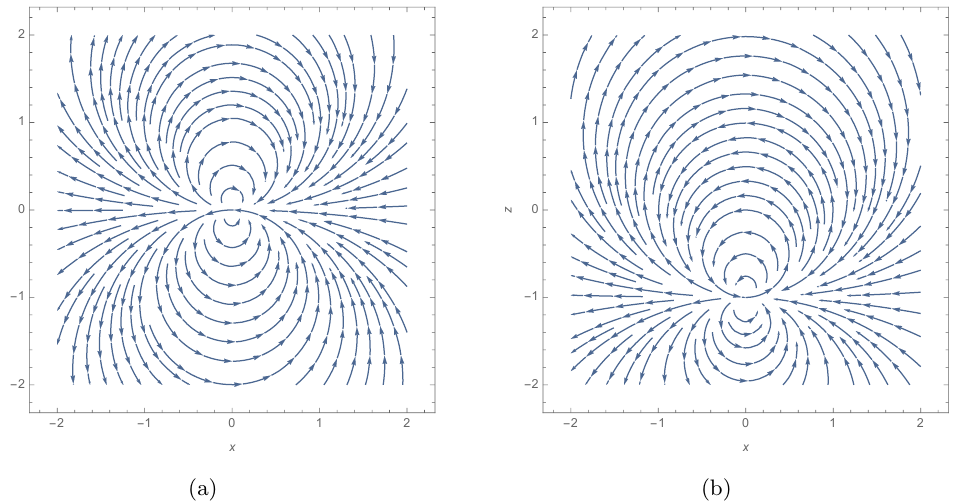
Figure 4 . The real part of the electric (cid:12)eld of the Eguchi-Hanson single copy, using Cartesian coordinates in Minkowski signature: (a) for ( t; y ) = (0 ; 0); (b) for ( t; y ) = (1 ; 0). The imaginary part is